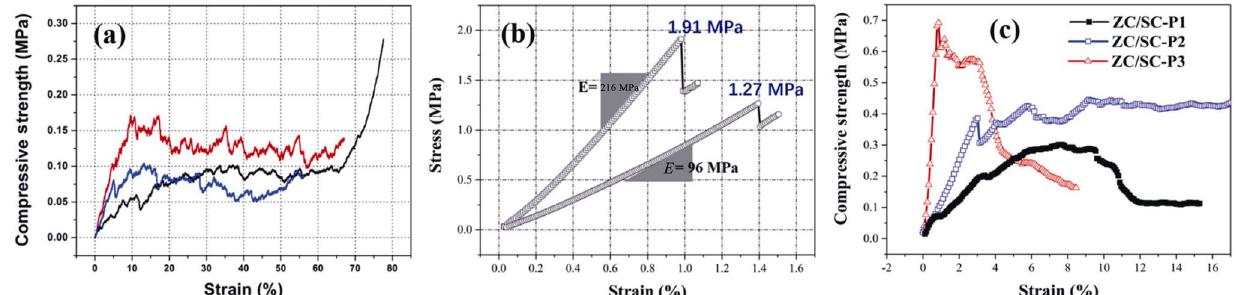
Fig. 13 Compressive stress–strain curves of the sol–gel derived porous UHTCs. (a) ZrC foams prepared by foaming method [37]. Reproduced with permission from Ref. [37], © IntechOpen 2019. (b) Porous ZrB 2 /ZrC/SiC ceramics prepared by